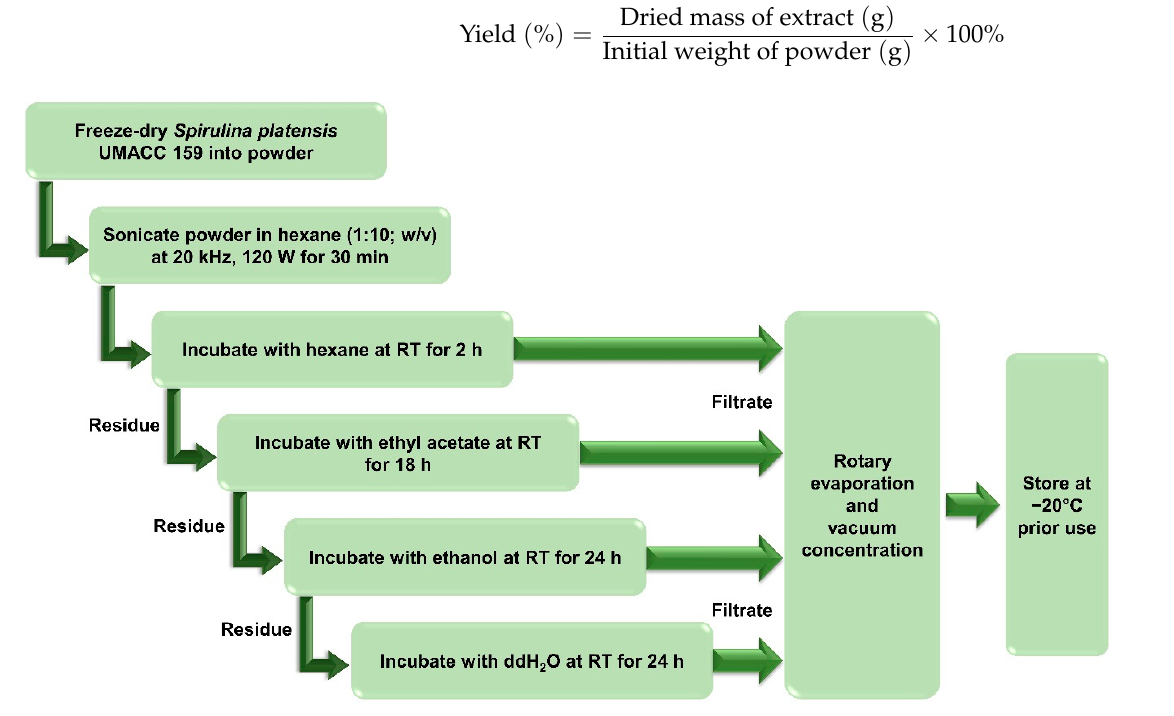
Figure 1. Preparation of S. platensis extracts using ultrasound-assisted extraction (UAE) and sequential extraction (SE). RT: room temperature; ddH 2 O: double distilled